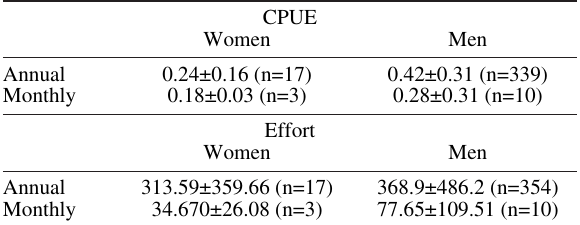
Table 4. – Madeiran anglers CPUE (kg/angler/hour) and effort (in hours) stratified by sex and licence duration. CPUE Women